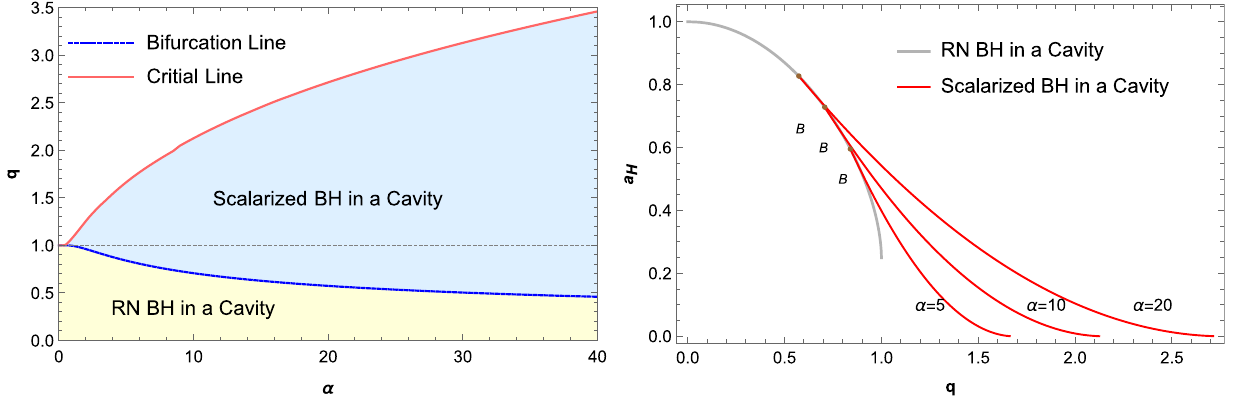
extremalRNblackholesincavity,abovewhichRNblackholesolutions in a cavity do not exist. Right panel: Reduced area a H versus reduced charge q for RN black holes (a gray line) and scalarized RN black holes with various values of q (red lines). For a given q , a H of the scalarized RN black hole in a cavity is larger than that of the RN black hole, and increases with the growth of α . The scalarized black hole solutions are always entropically preferred